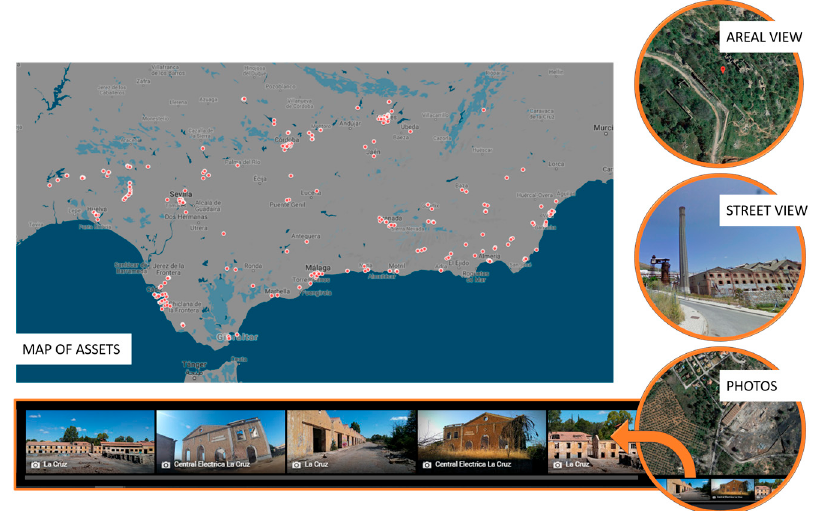
Figure 7. Functions included in Google Maps.